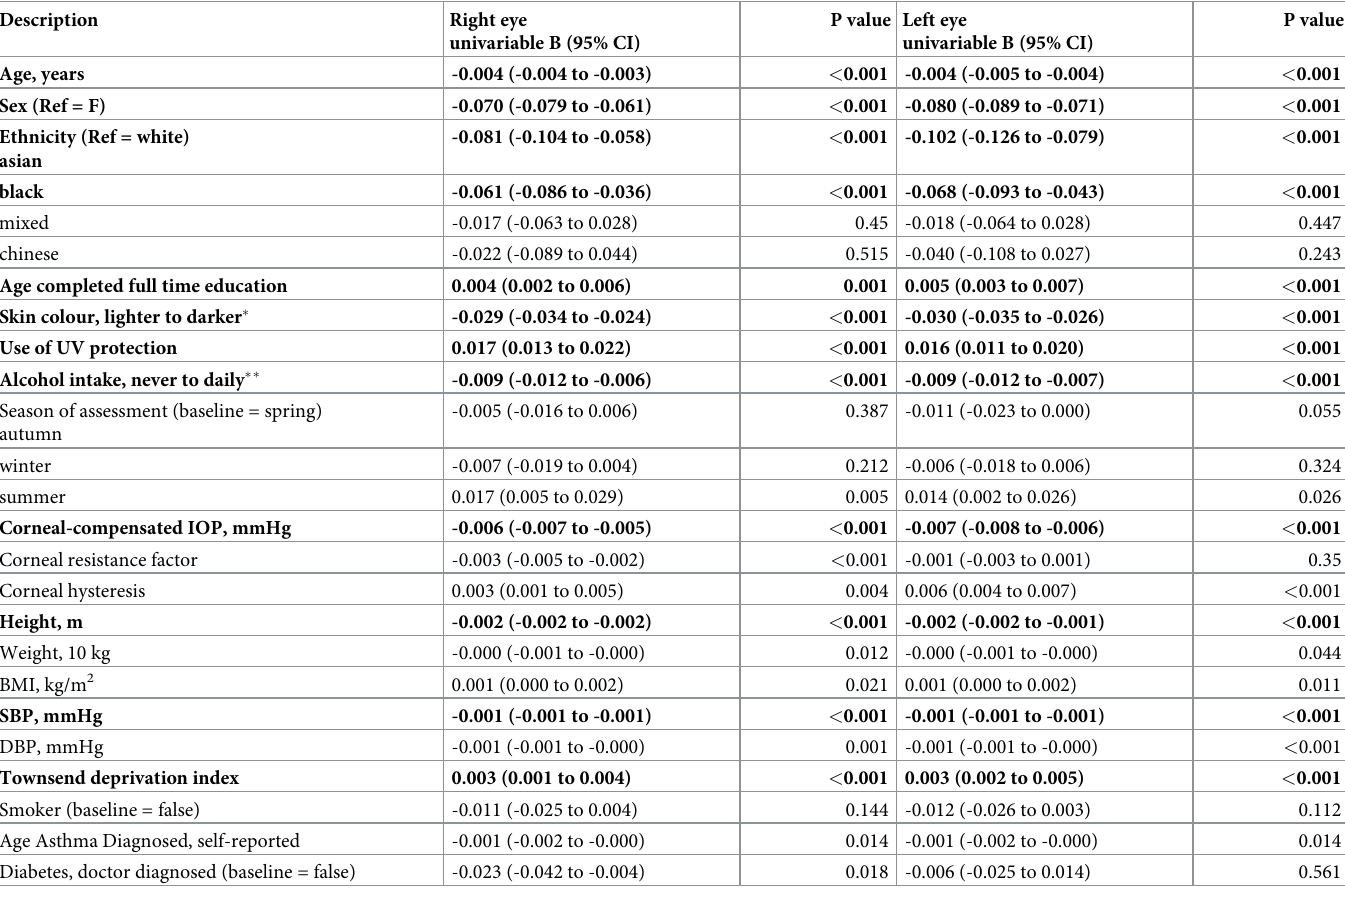
Table 3. Results of univariable regression in 83,751 study participants in the UKBB for right and left eye corneal astigmatism. Significant associations are highlighted in bold. P values for B coefficients are derived from a t-test. 95% CI = 95% confidence interval.